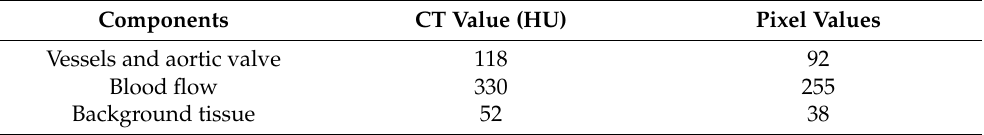
Table 3. CT values and normalized pixel value of each component in the motion